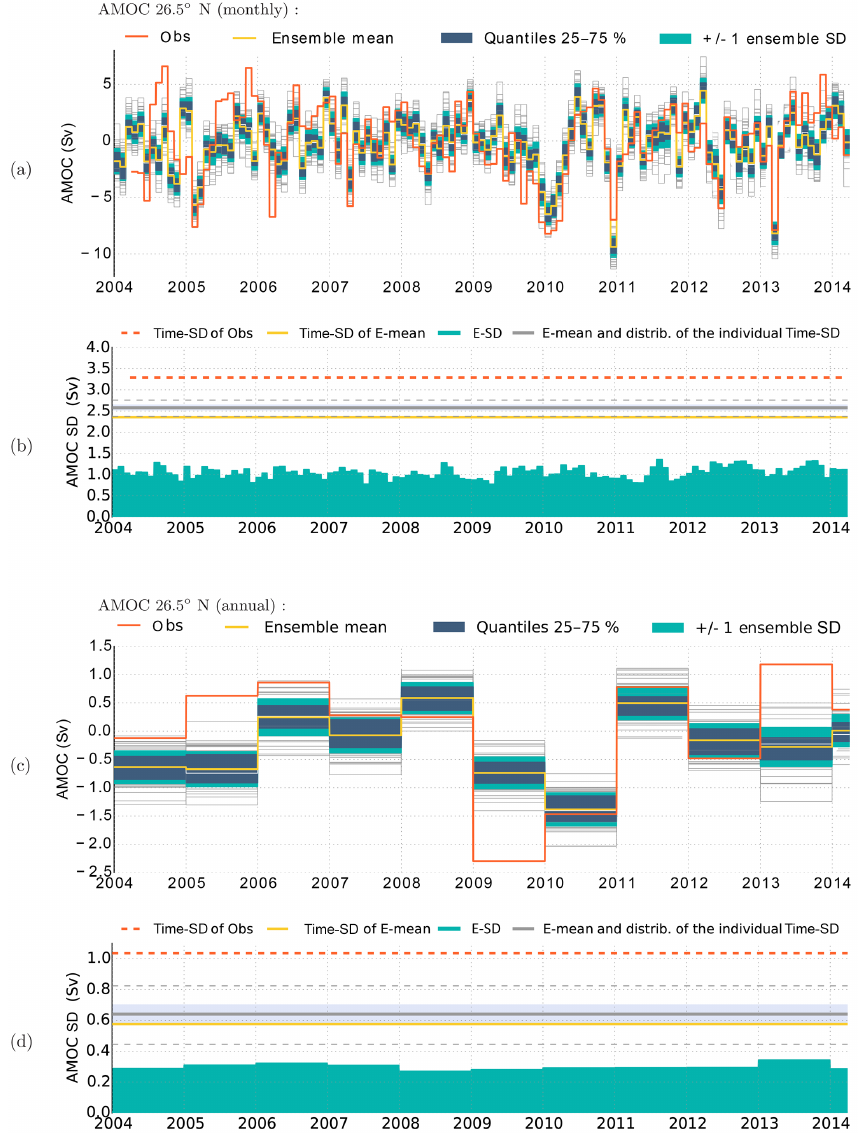
Figure 6. Same as Fig. 4 but for AMOC anomalies at 26 ◦ N in the global ensemble E-ORCA025, from (a, b) monthly and (c, d) annual means. In addition, AMOC observational estimates from RAPID at 26 ◦ N are shown in orange (see text for